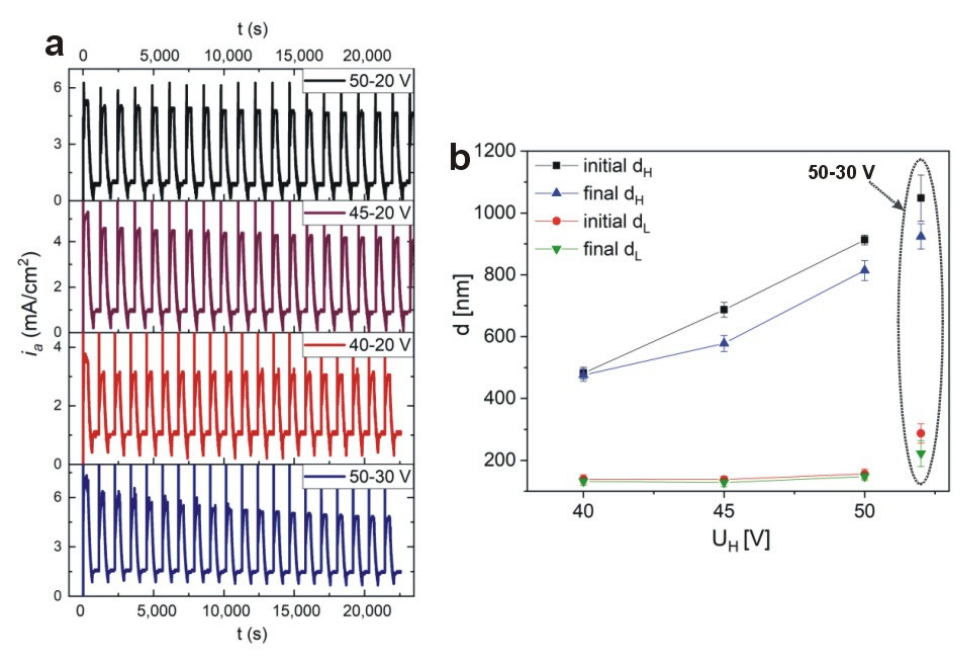
Figure 9. Current density i a ( t ) recorded during pulse anodization of aluminum under the following U H -U L potentials: 50–20 V, 45–20 V, 40–20 V, and 50–30 V (t H = 360 s, t L = 480 s, 20 cycles, 10 °C) ( a